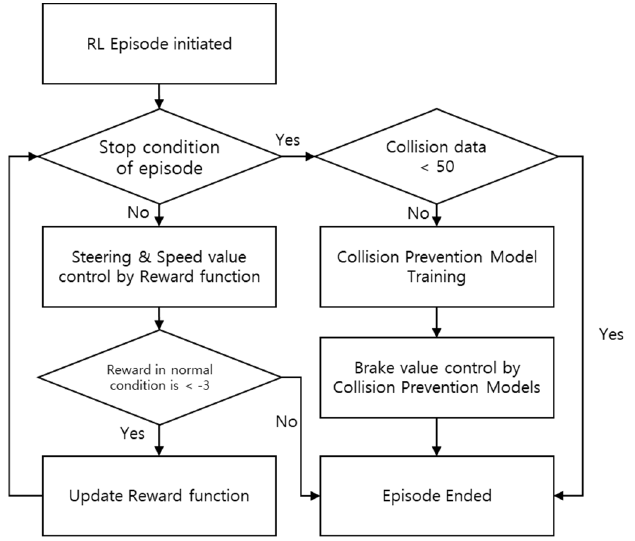
Figure 6. Flowchart of training for episodes of reinforcement learning.